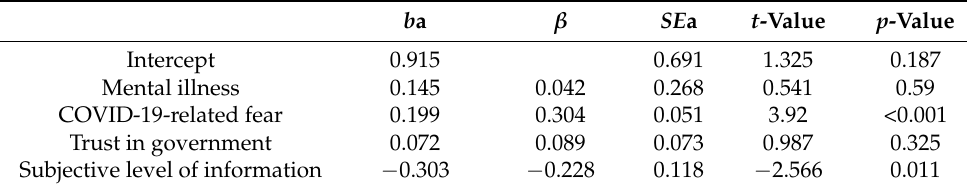
Table 4. Regression coefficients predicting an increase in generalized anxiety symptoms